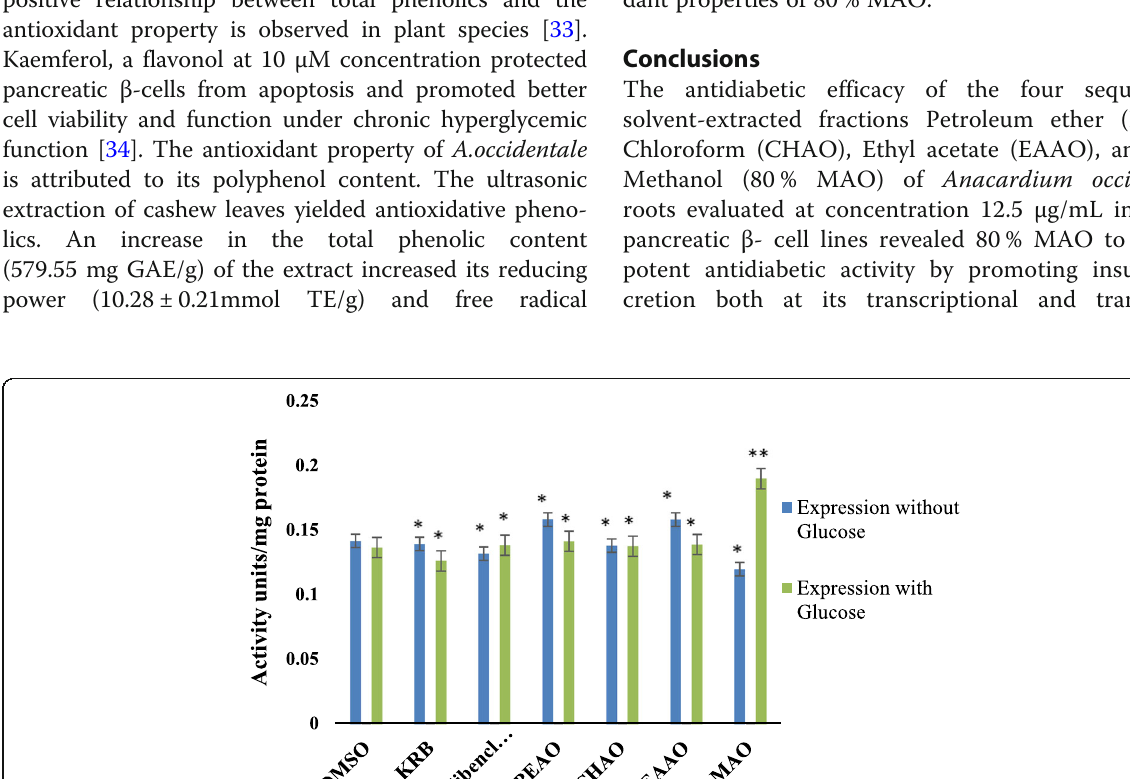
PEAO Petroleum ether extract of A. occidentale , CHAO Chloroform extract of A. occidentale , EAAO Ethyl acetate extract of A. occidentale , 80% MAO 80% Methanol extract of A. occidentale *Results are expressed as mean±SD ( n =3). P ˂ 0.05 vs. control